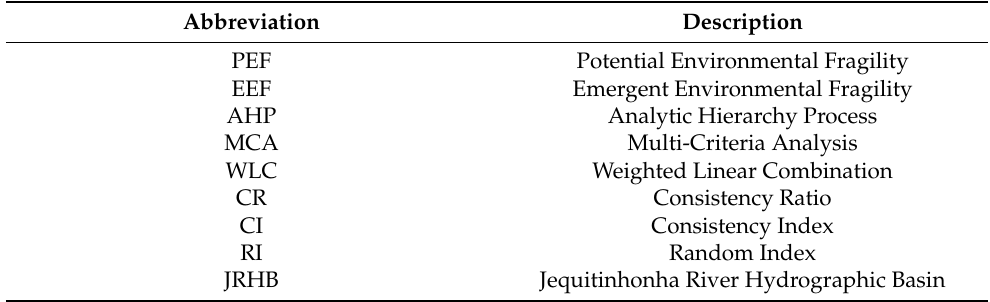
Table 3. Informative auxiliary table with a description of the abbreviations used in the